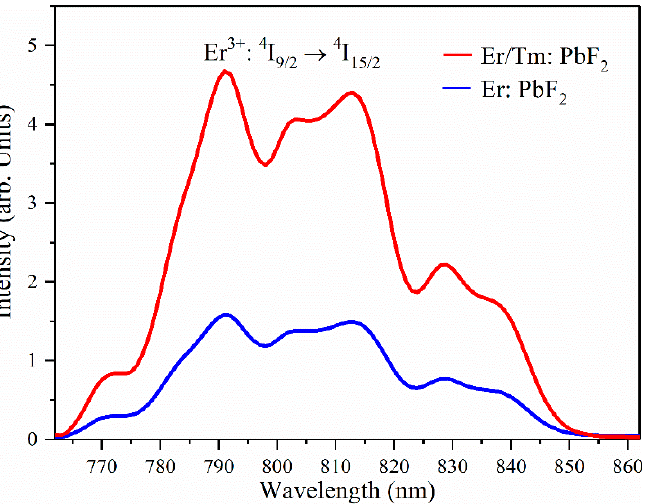
Figure 8. Up-conversion emissions of Er: PbF 2 , and Er/Tm: PbF 2 crystals in the range of 760–860 nm ( λ ex = 980nm) .